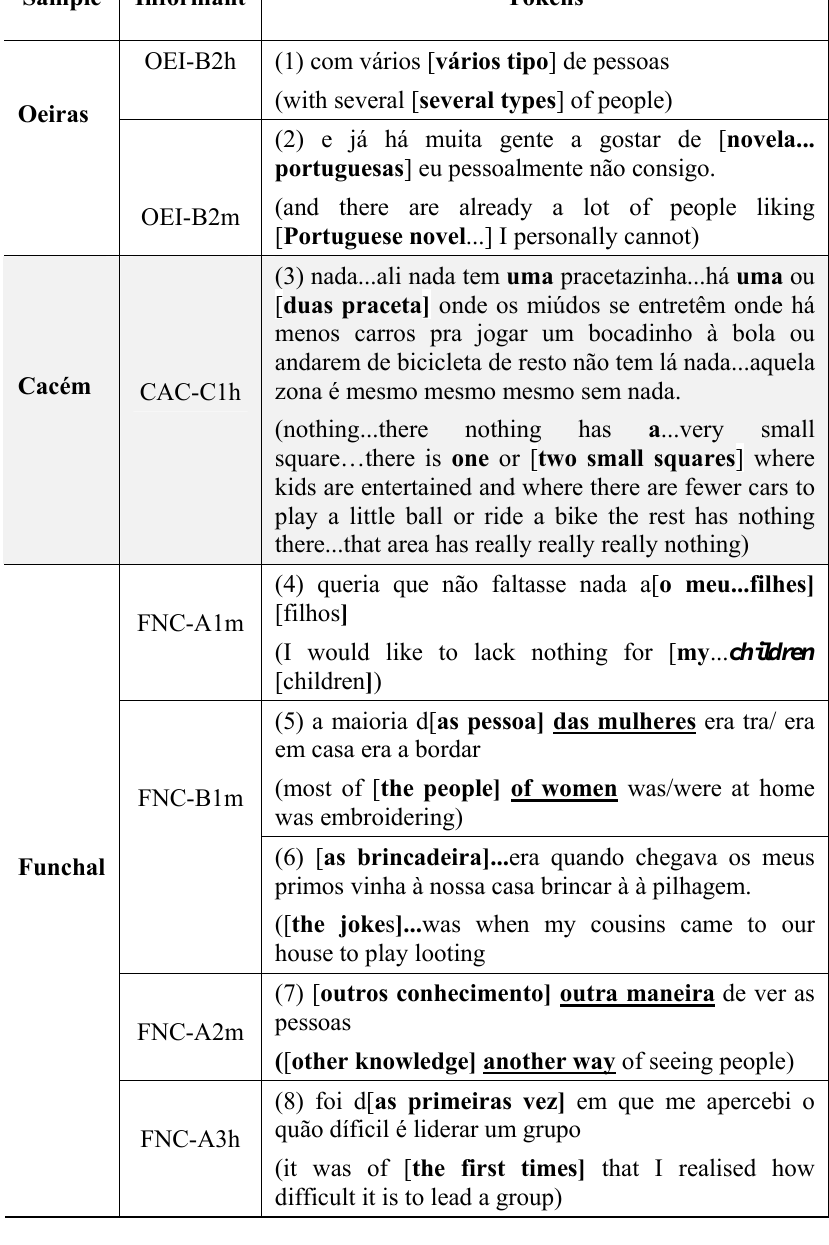
Table III. Tokens of NPs without number mark(s) within the three EP samples